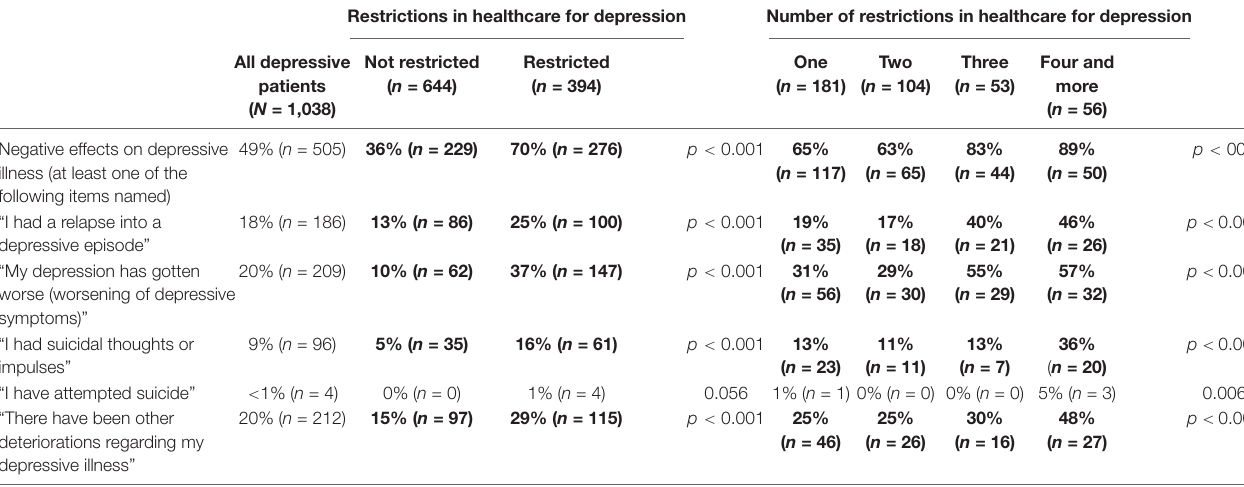
TABLE 1 | Associations of COVID-19 restrictions and healthcare for depressive disorders. Restrictions in healthcare for depression Number of restrictions in healthcare for